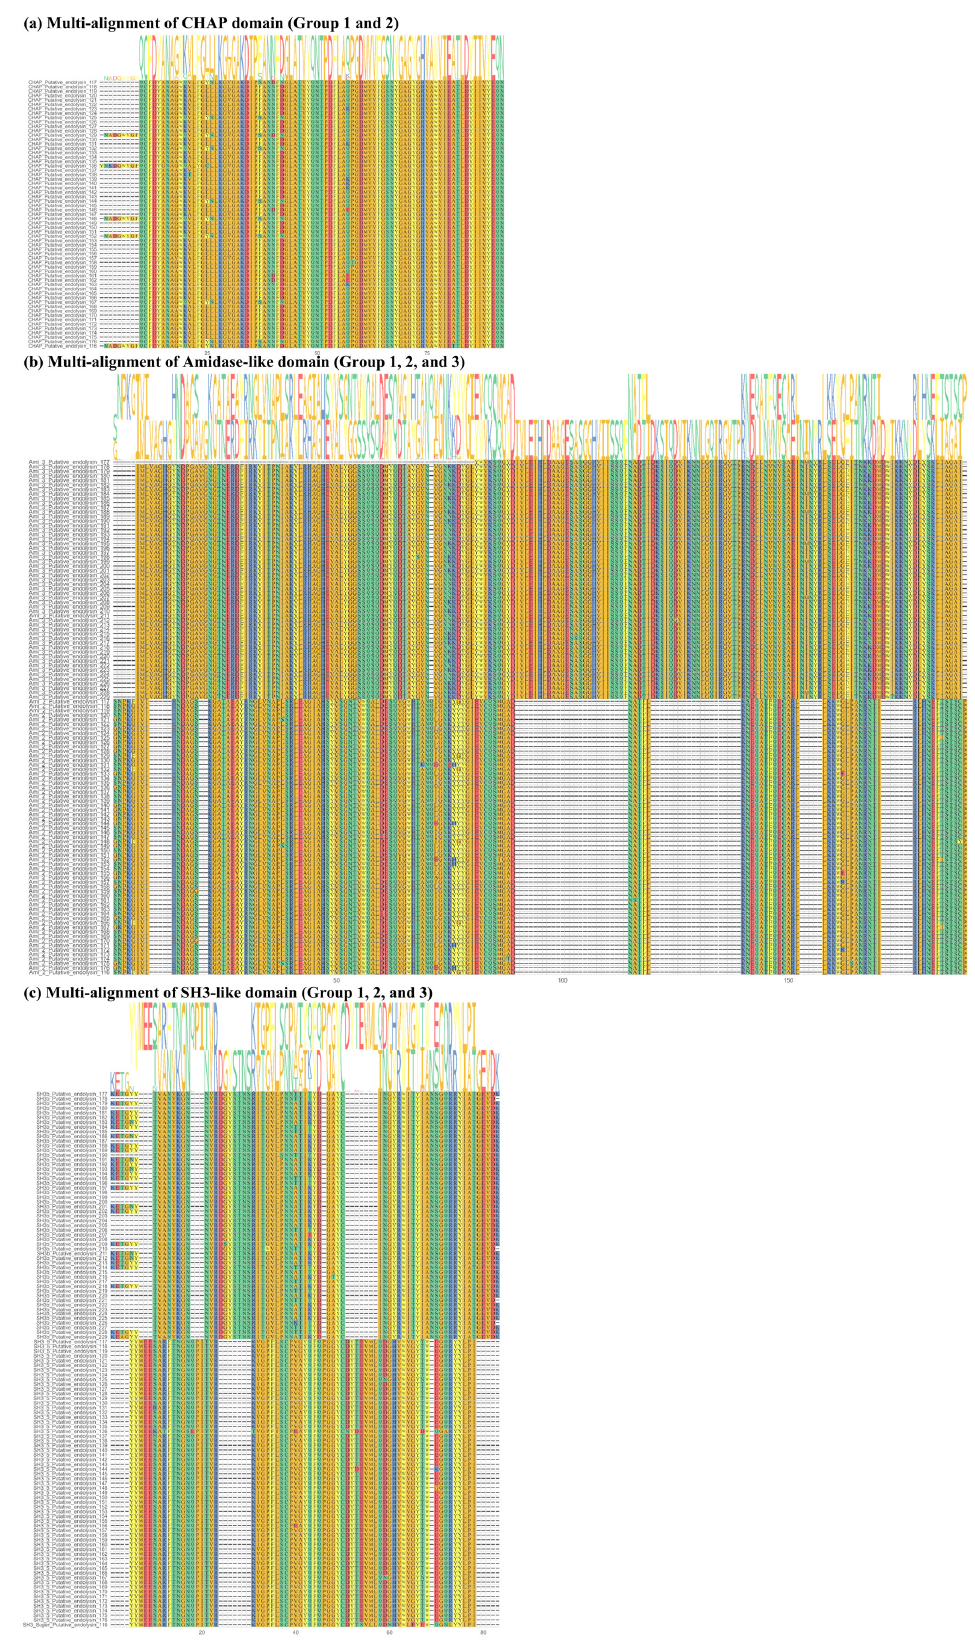
Figure 3. Multi-alignment of all putative endolysins with an enzymatically active domain and a cell wall binding domain based on amino acid sequences. ( a ) Multi-alignment of the cysteine,